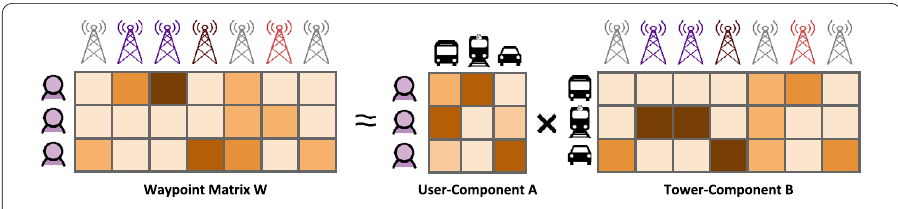
Figure 2 Depiction of the Non-Negative Matrix Factorization (NMF) stage of the proposed pipeline. We built a WaypointMatrix W where rows encode users and columns encode towers, in analogy to document-term matrices. A cell in W denotes how frequently its corresponding user connects to its corresponding tower while commuting. The NMF decomposes W into two matrices that can be interpreted as the association between users and latent components ( A ), and towers and latent components ( B ). To interpret these latent components as modes of transportation, we used a Semi-Supervised approach to perform the